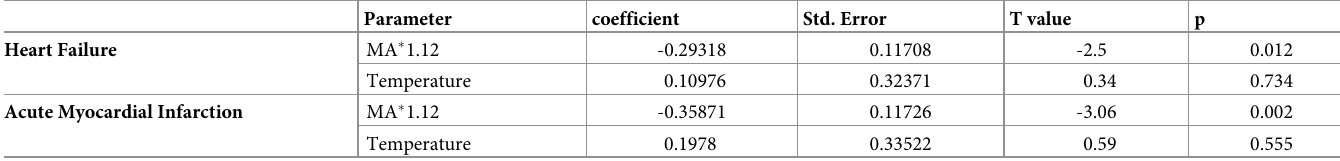
Table 3. ARIMA analysis on the seasonal variation of the rates of hospitalizations for acute myocardial infarction and heart failure, and on the association between hospitalization rates and temperature